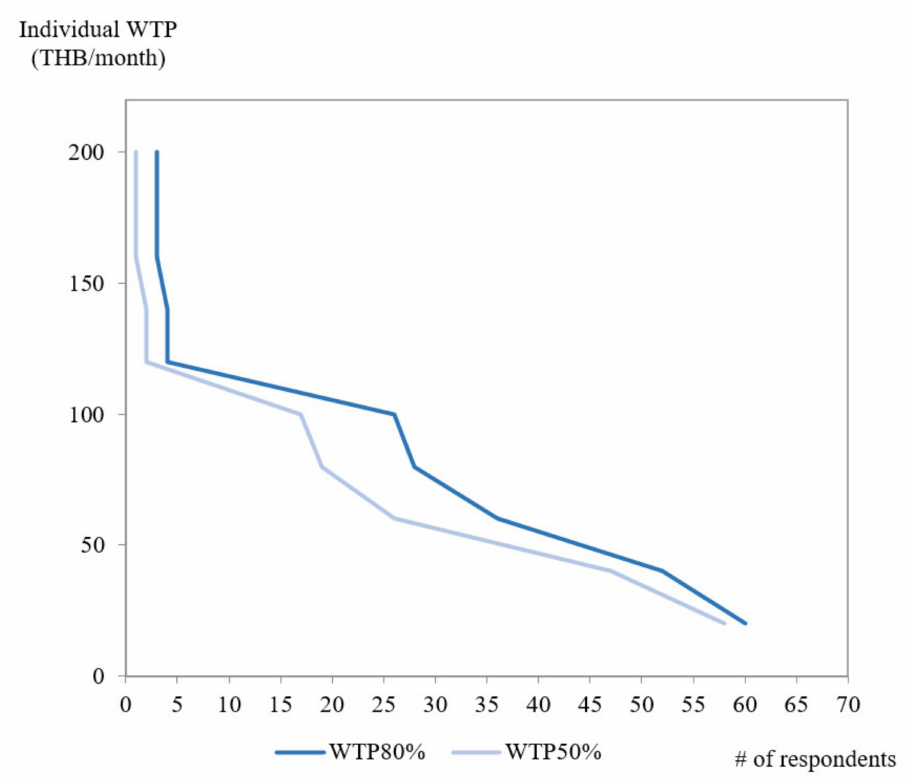
Figure 3. Relationship between the individual willingness to pay (WTP/month) and the number of respondents for the 50% and 80% atmospheric pollution mitigation